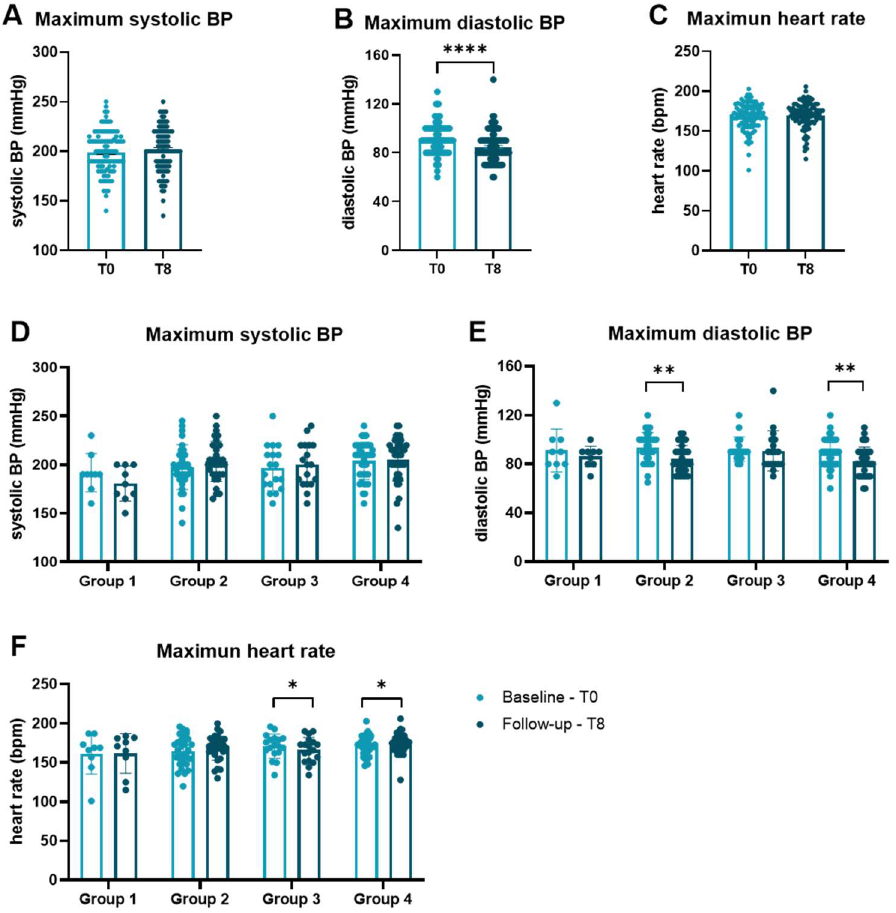
Figure A2. Maximum heart rate and blood pressure during cardiopulmonary exercise. Heart rate and blood pressure were measured at baseline and after 8 months during the bicycle stress test every two minutes, and peak values were documented. ( A ) Systolic BP, ( B ) diastolic BP, and ( C ) heart rate were compared between baseline and follow-up. After categorization according to initial fitness and performance gain, ( D ) systolic BP, ( E ) diastolic BP, and ( F ) heart rate are compared separately for each group by Wilcoxon matched-pairs signed rank tests. Data are presented as scatter dot plots with mean ± SEM. * p < 0.05, ** p < 0.01, **** p < 0.0001. BP blood pressure, bpm beats per minute, SEM standard error of the mean. Table A2. Bonferroni–Holm-corrected p -values for cfDNA. Table A1. Correlations of clinical parameters with cfDNA and DNase activity. Parameter cfDNA DNase Group R s p -Value Sig. R s